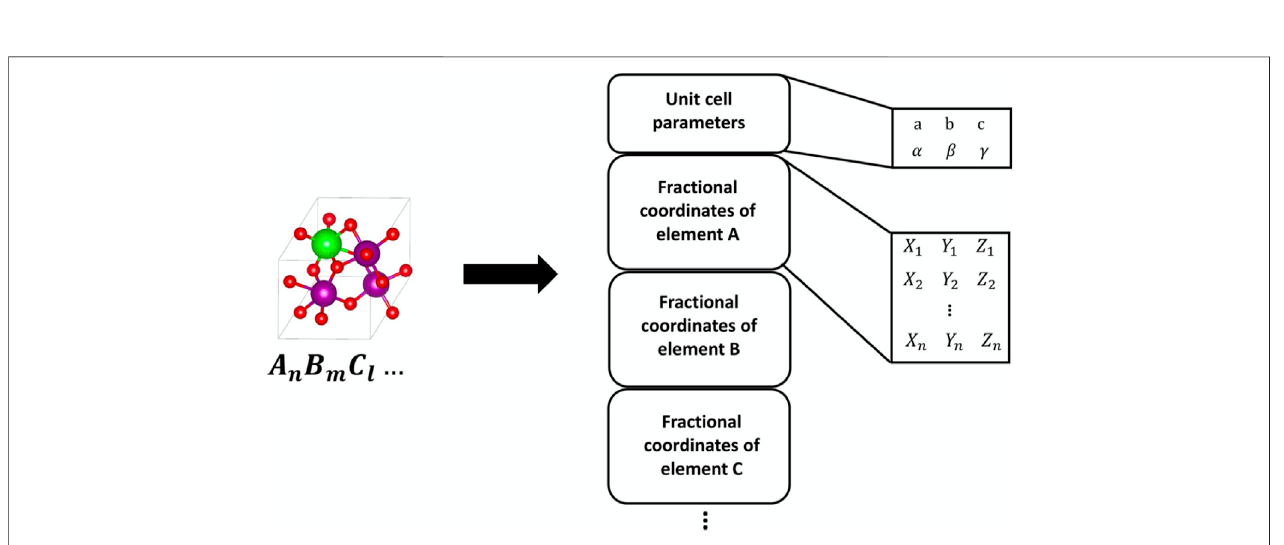
FIGURE 5 | Example of point cloud approach to structure representation. Reprinted with permission from Kim et al. (2020).